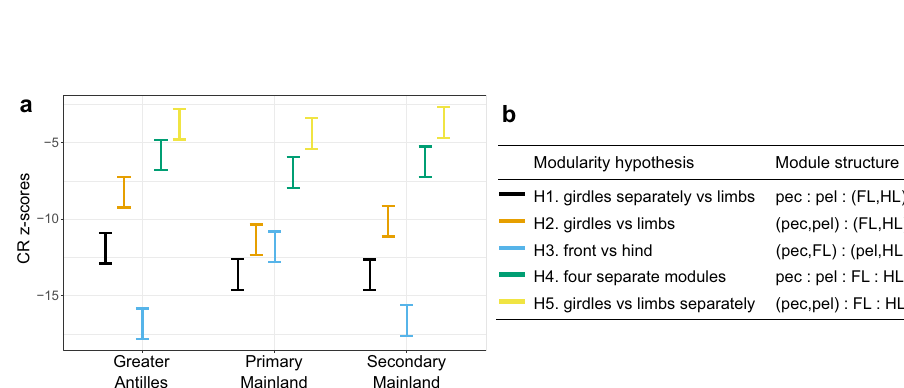
Fig. 1 Morphospace of the locomotor skeleton of Anolis lizards. a Phylogenetic relationship between major groups of Anolis lizards. The number of species per group included in this study, the total number of species, and the resulting percentages, are given in brackets and are proportional to the height of the triangles in the phylogram. The deepest split within Anolis marks the dispersal of mainland forms to the Greater Antillean islands. One lineage derived from the Greater Antillean lineage has recolonized the mainland (Secondary Mainland clade). The Lesser Antilles has been colonized from two different sources, once from the Primary Mainland clade and once from the Greater Antillean lineage. The timeline indicates the age of the major divergences as reported by Poe et al. 26 . b The fi rst three principal components of the locomotor skeleton of all 271 species included in this study in a 3D morphospace. The two sister species, A. porcus and A. chamaeleonides , have undergone an extreme shift in morphospace along the fi rst PC, approaching the position of distantly related genera. Pictures show an A. bimaculatus representing the second most “ average ” Anolis species (i.e., closest to the centroid described by PC1 – 3 of all Anolis species), a Corytophanes cristatus representing distant relatives to Anolis , and an A. porcus representing the two species with the most extreme shifts in Greater Antilles show a higher morphological disparity compared to the 107 species of the Secondary Mainland clade and to the 21 species of the Lesser Antilles (see also and Supplementary Tables 3 and 4). Large circles mark the inferred position of the most recent common ancestor (MRCA) of the three